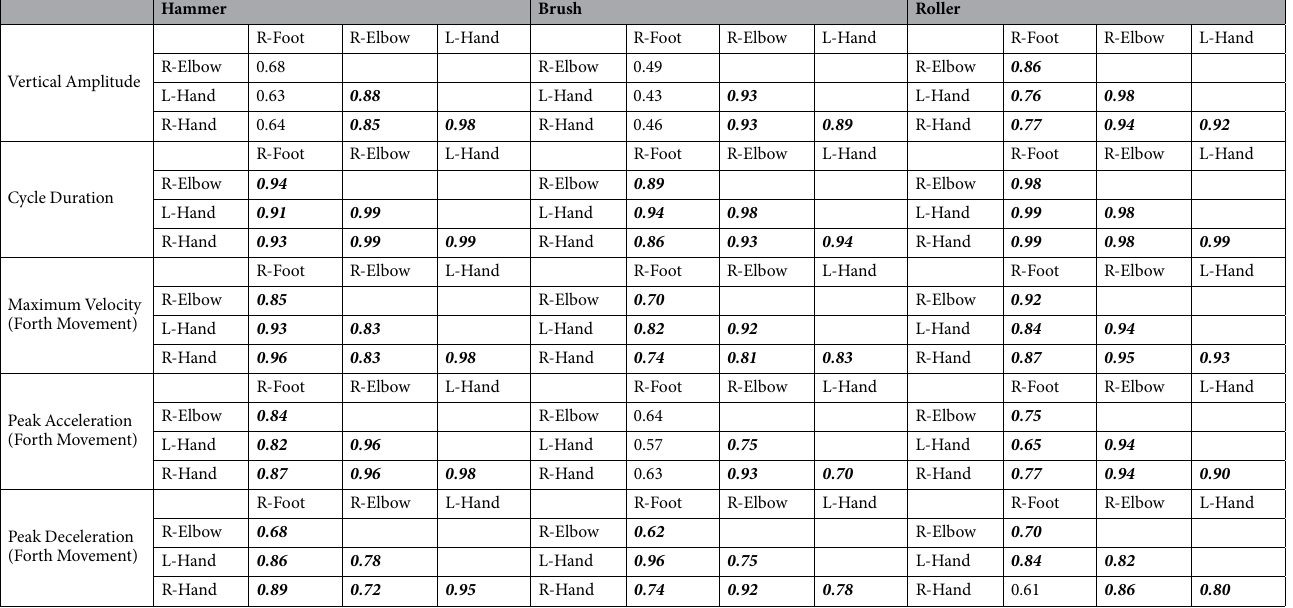
Table 1. Correlations between end-effectors for each tool and each parameter of interest. R, Right; L, Left; Bold, italicized values are statistically significant. For each matrix, Holm’s correction was applied with an overall p -value of 0.05. Correlations are Pearson correlation coefficients ( n = 10). Additional post-hoc power analyses 38 were performed: for r > 0.80: Power > 0.80; for 0.75 < r < 0.80: 0.70 < Power < 0.80; for r < 0.75: Power <